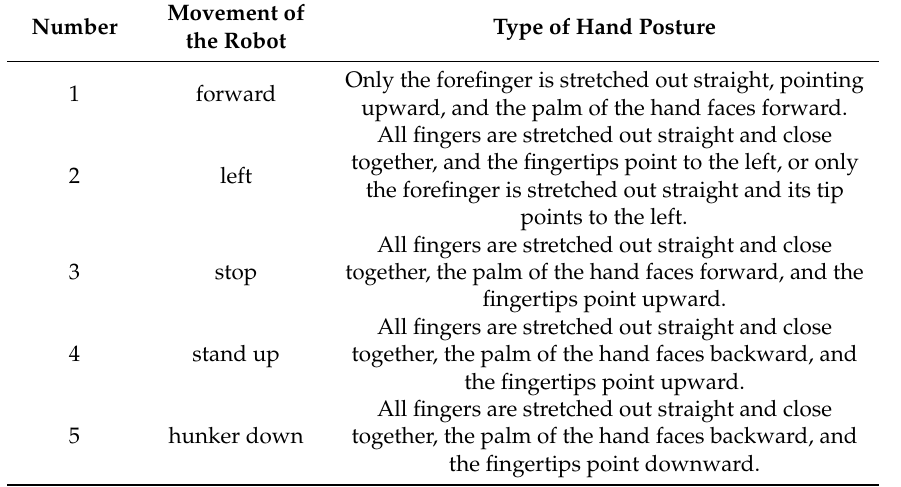
Table 2. Mapping the movements of the hexapod robot.